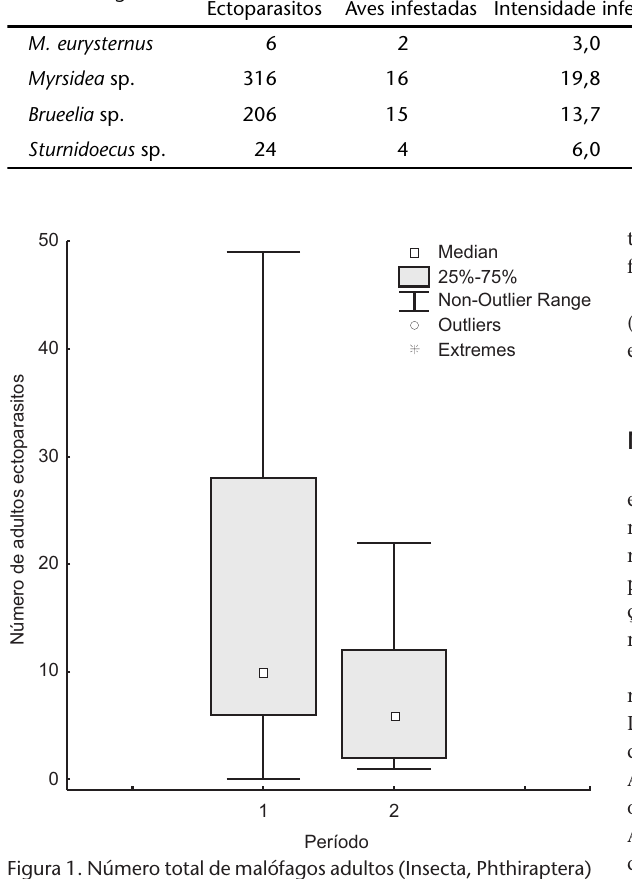
Figura 1. Número total de malófagos adultos (Insecta, Phthiraptera) em Turdus leucomelas (Passeriformes, Turdidae) na estação reprodutiva (1) (outubro e dezembro 2006) e estação de troca de penas (2) (março 2007) no Parque Estadual do Rio Preto, Minas Gerais,